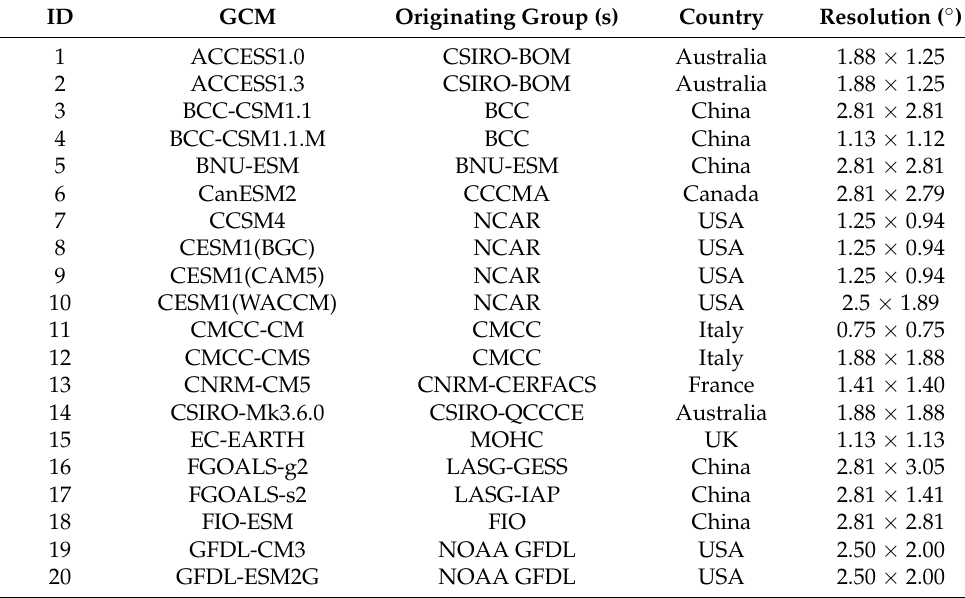
Table 2. Summary of 40 general circulation models (GCM) selected in this